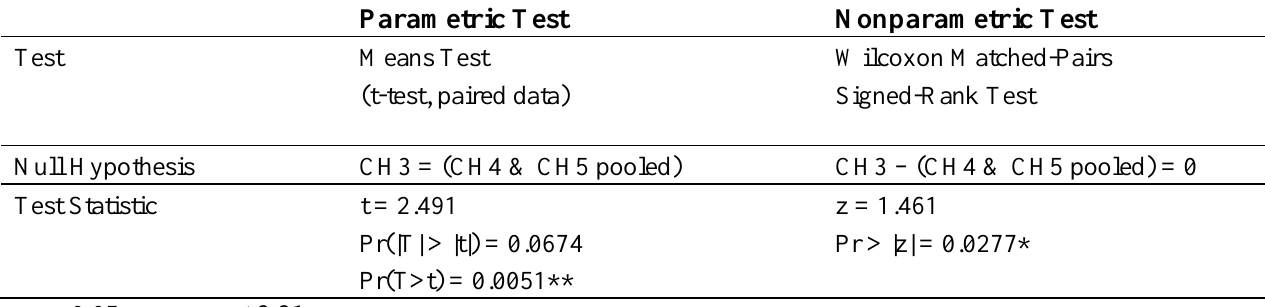
Table 5. Parametric and nonparametric tests of avg. Type Y data for CH3 and pooled CH4 and CH5. Parametric